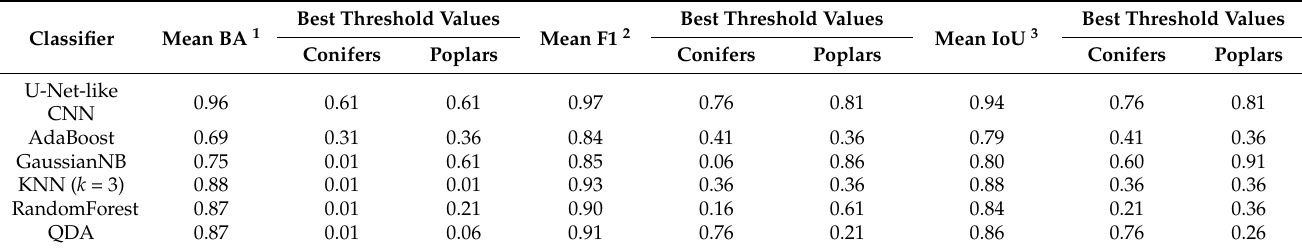
Table 1. Comparison of traditional machine learning (ML) methods and the U-Net-like convolutional neural network